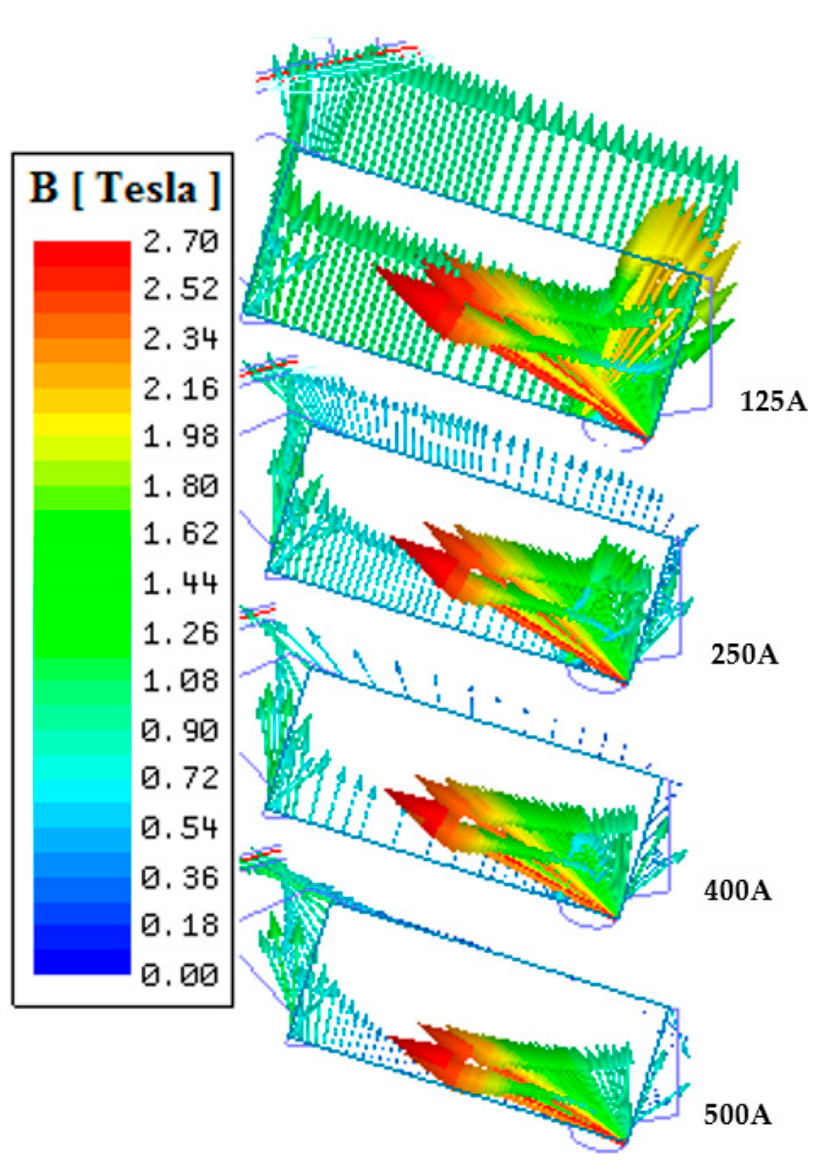
Figure 11. Flux density vectors of PMs for various electric loadings.